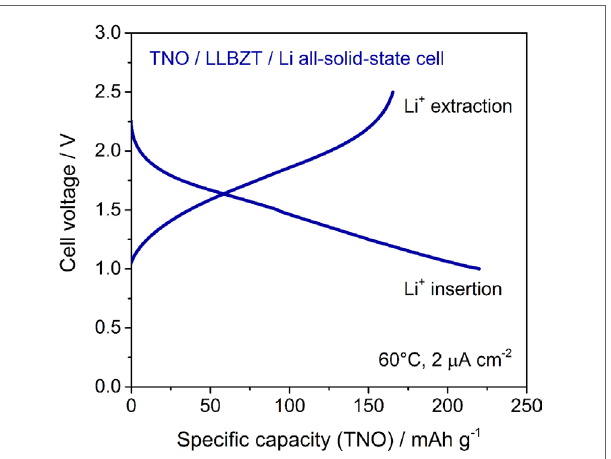
FigUre 12 | a cyclic voltammogram measured at 60°c and a scanning rate of and 0.1 mV s − 1 for TnO film electrode/llBZT/li all-solid-state cell .